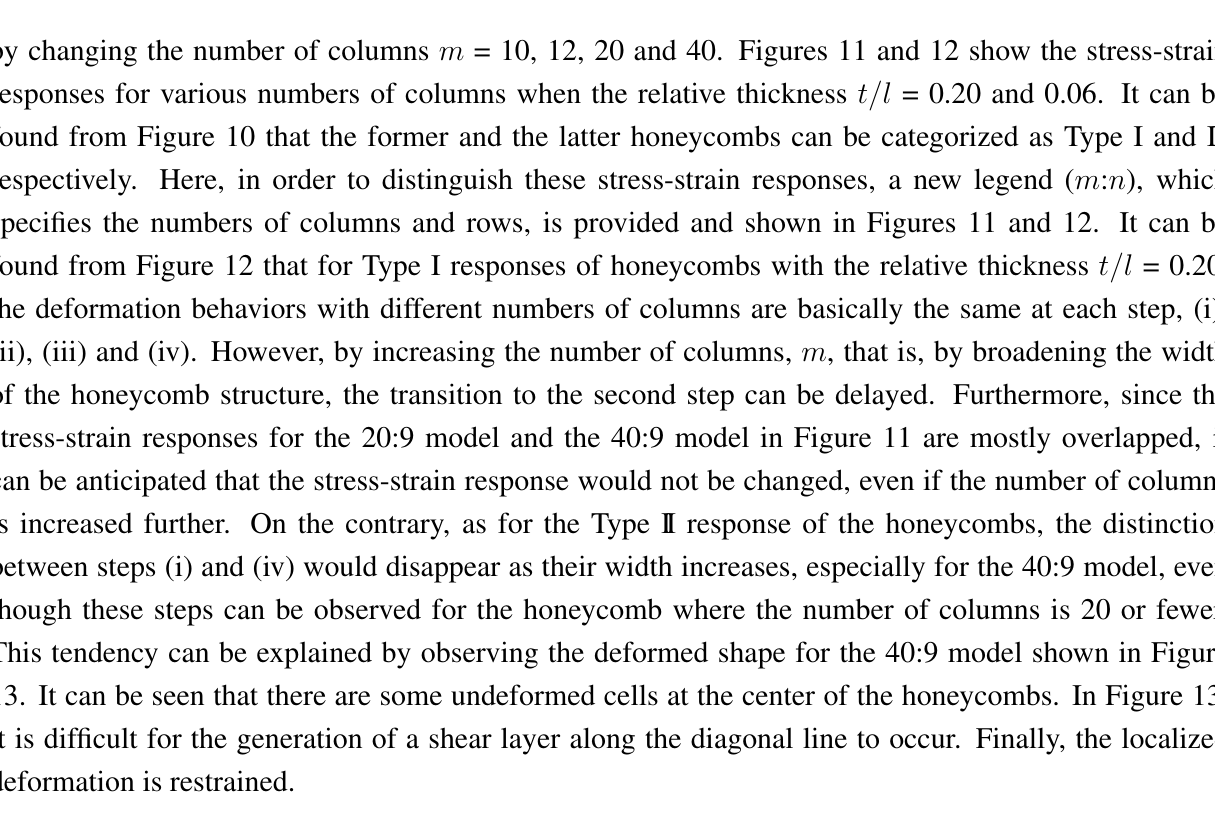
Figure 11. Stress-strain responses for various honeycomb widths under the same cell’s thickness to length ratio t/l = 0 . 20